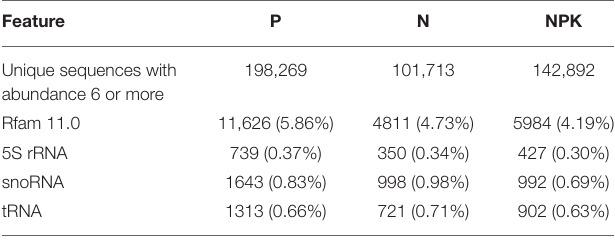
TABLE 1 | Annotation of reads from flax small RNA